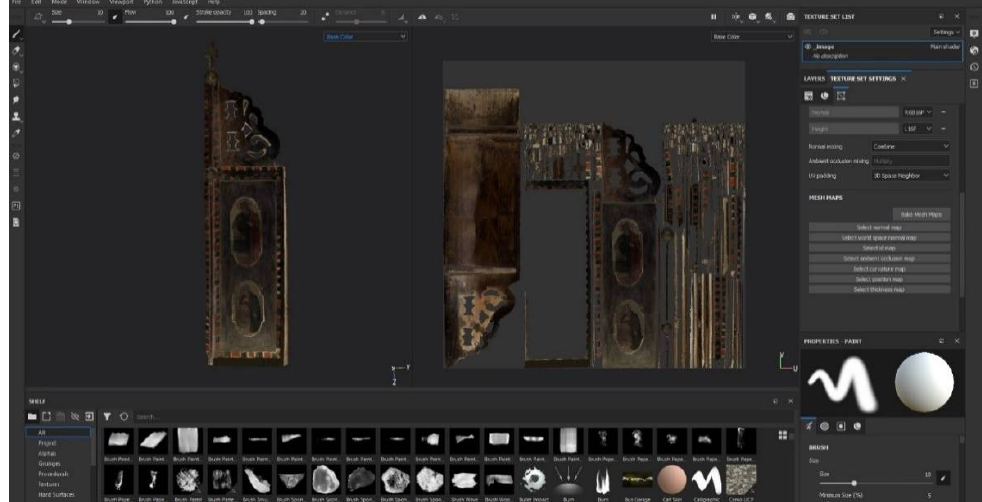
Figure 17. The recolored model of the right-side door of the imperial gates from